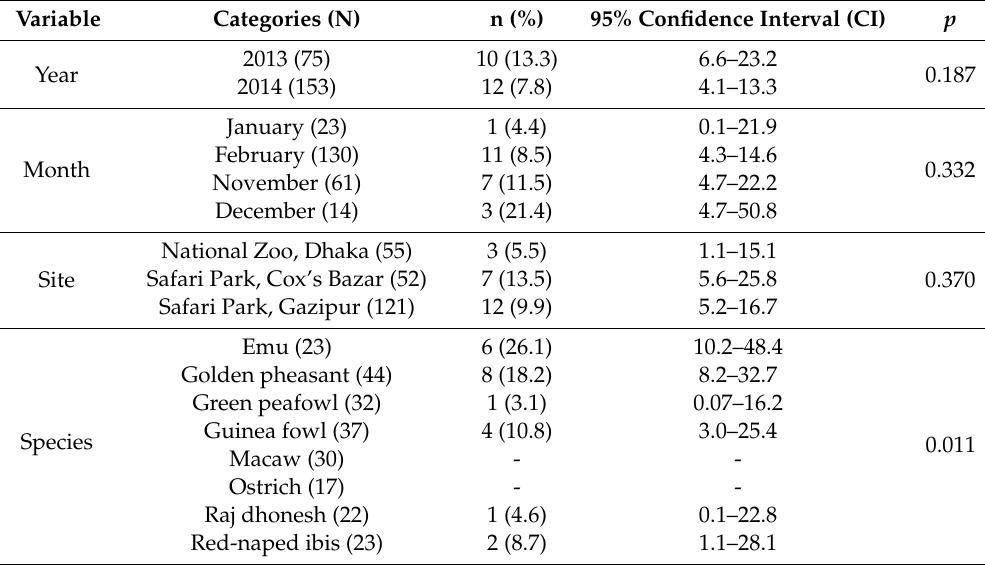
Table 1. Univariate association between di ff erent factors and avian influenza A viruses (AIV) antibody positive samples (n =